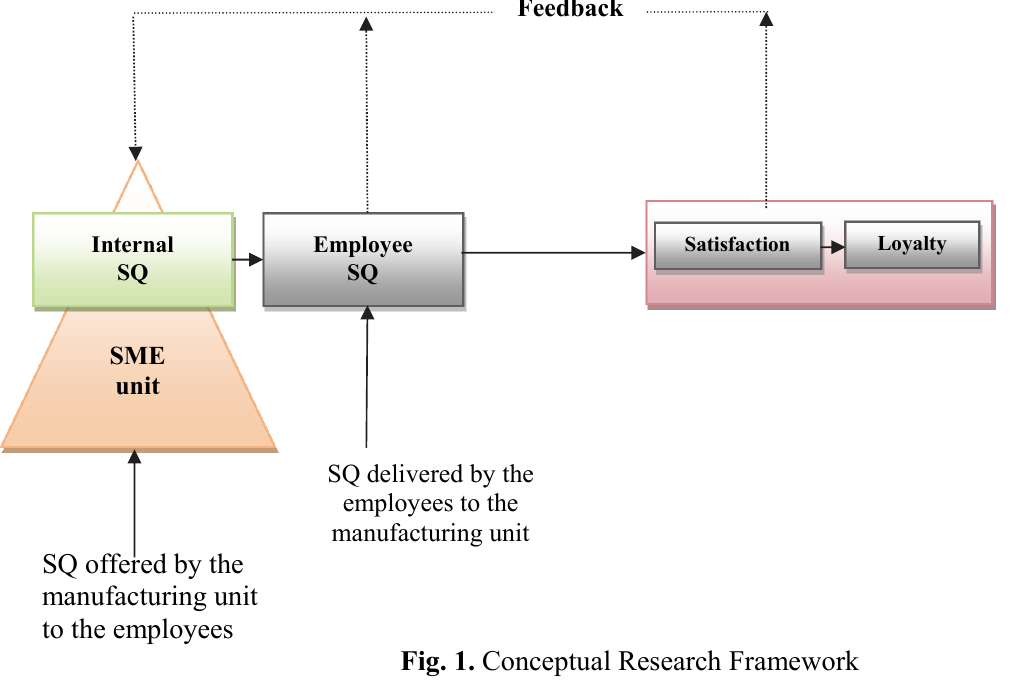
Fig. 1. Conceptual Research